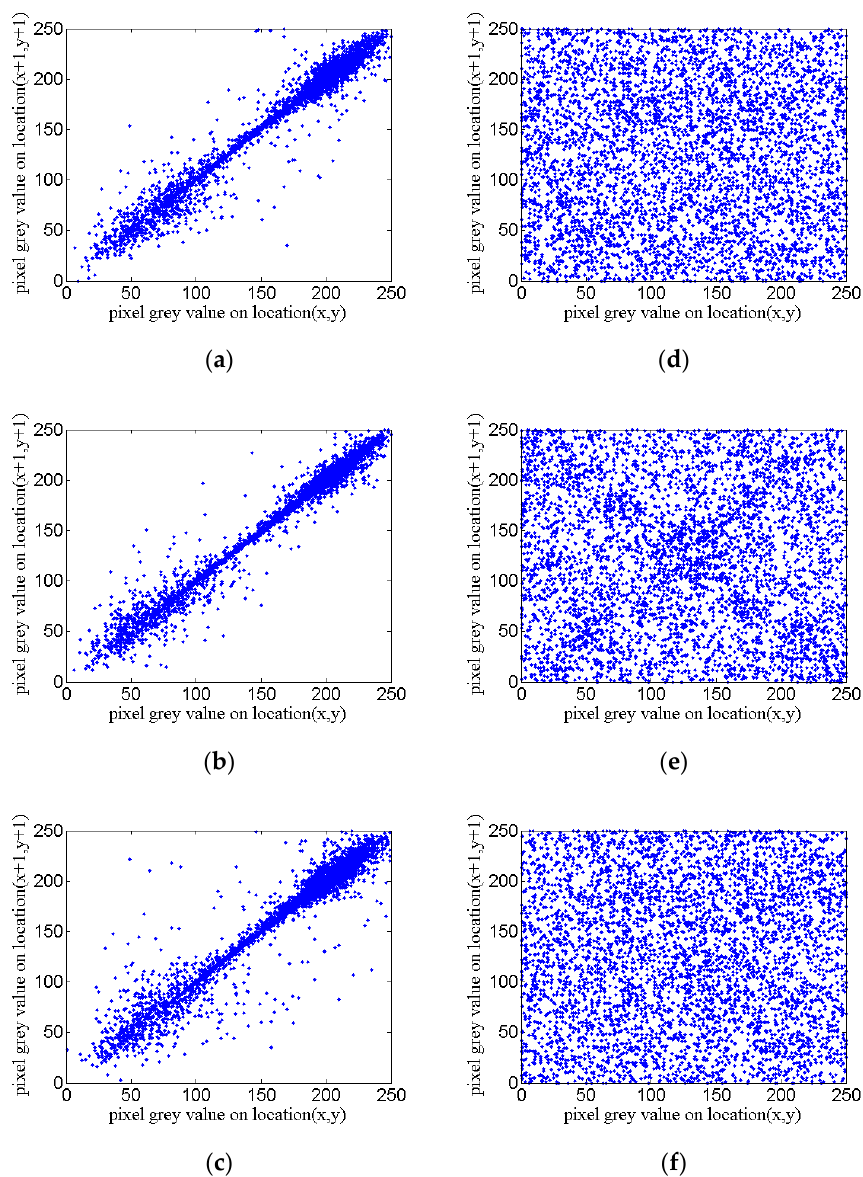
Figure 14. The comparison tests of correlation coefficient before and after waterfront image encryption: ( a ) the horizontal correlation coefficient before encryption; ( b ) the vertical correlation coefficient before encryption; ( c ) the diagonal correlation coefficient before encryption; ( d ) the horizontal correlation coefficient after encryption; ( e ) the vertical correlation coefficient after encryption; ( f ) the diagonal correlation coefficient after encryption.